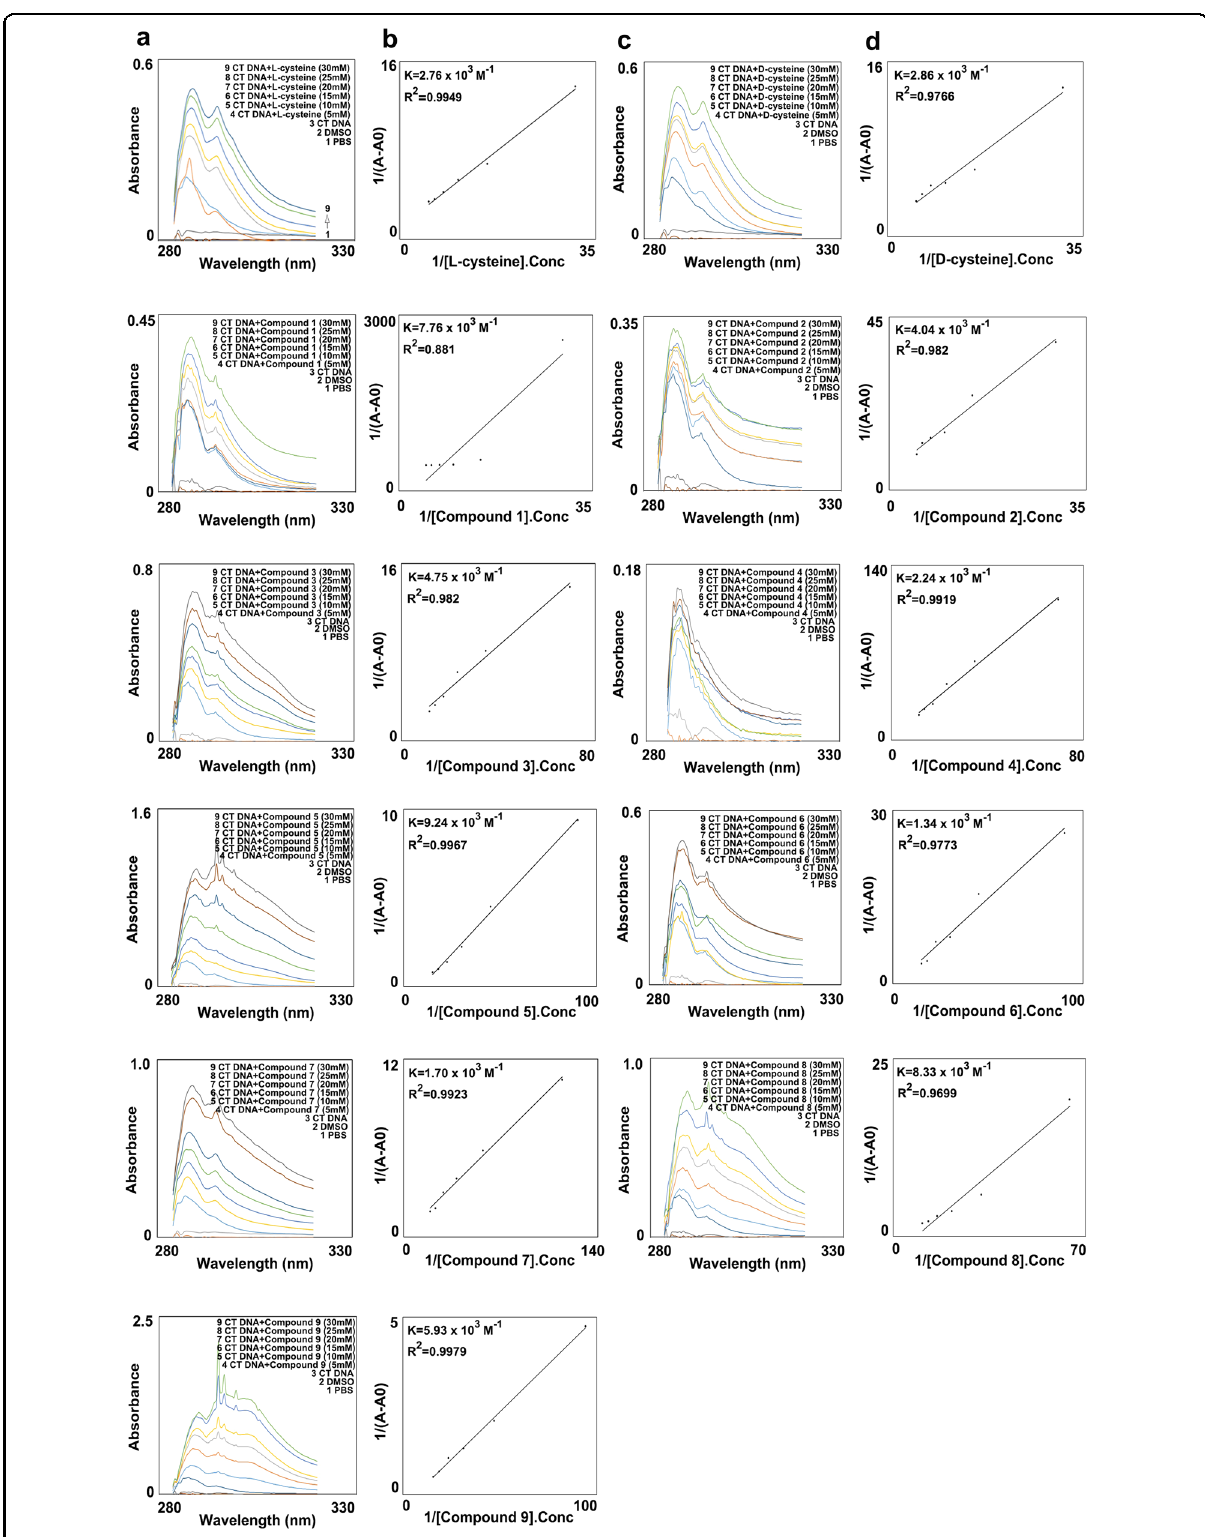
Fig. 2 Binding capability of calf-thymus DNA and compounds. a , c Absorption spectra of CT DNA in the absence and presence of increasing concentrations of small molecular compounds, 5, 10, 15, 20, 25, 30 mM in DMSO-phosphate buffer (PH = 7.4) solution. b , d Plot of 1/( A − A 0 ) vs 1/[small molecular compounds]. Conc for calculation of binding constant ( K ) of